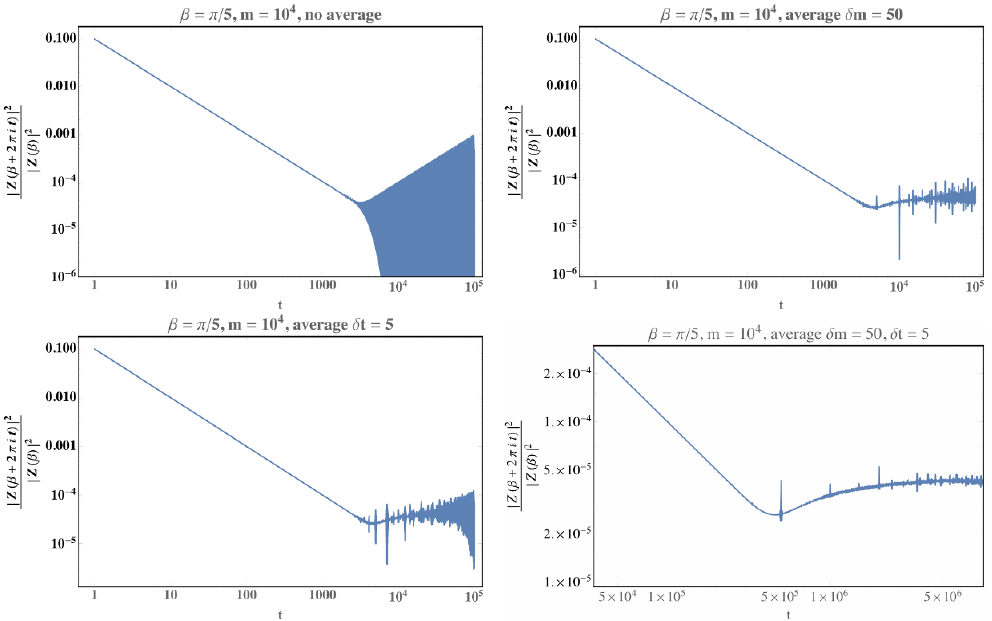
Figure 3 . Upper left: SFF of the m = 10 4 minimal model at (cid:12) = (cid:25)= 5 without any averaging. The plot depicts about one-third of the full recurrence time. This unaveraged SFF has a clear dip and the late time behavior is obscured by oscillation. Upper right: the same SFF only averaged over di(cid:11)erent m with a window of (cid:6) (cid:14)m = 50. Lower left: the same SFF only averaged over a gaussian time window of standard deviation (cid:14)t = 5, for integral time greater than 100. Lower right: the same SFF (cid:12)rst averaged over di(cid:11)erent m , then averaged over t , and zoomed in on the dip and plateau. The averaged behavior shows more clearly the ramp and